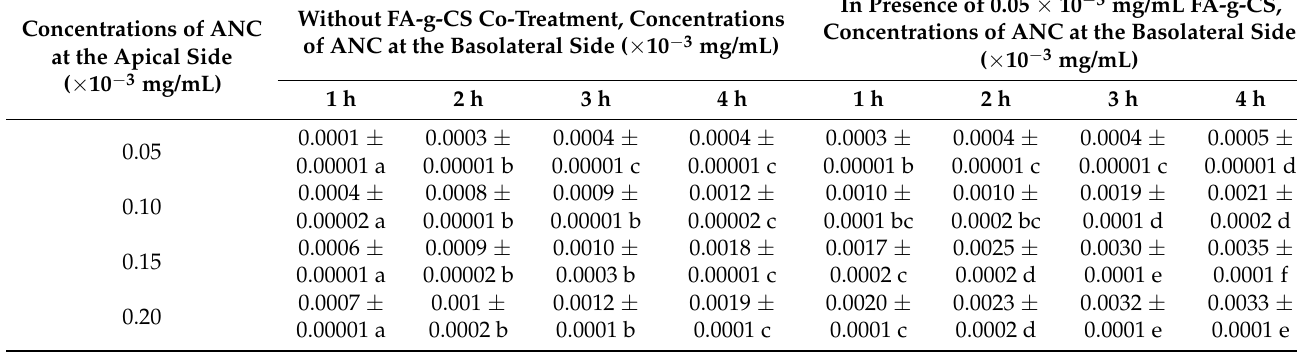
Table 4. ANC transmembrane transport in 4 h across Caco-2 cell monolayer in presence or absence of FA-g-CS.